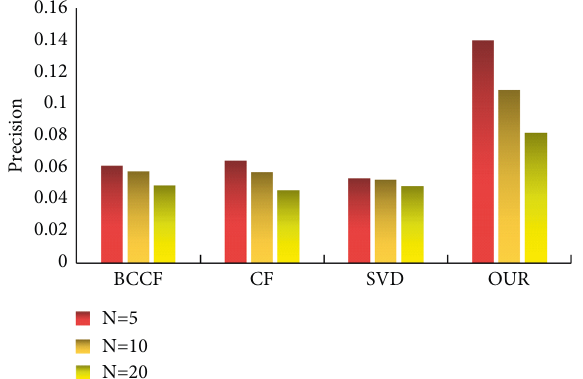
Figure 1: Comparison of precision on MovieLens 100k.